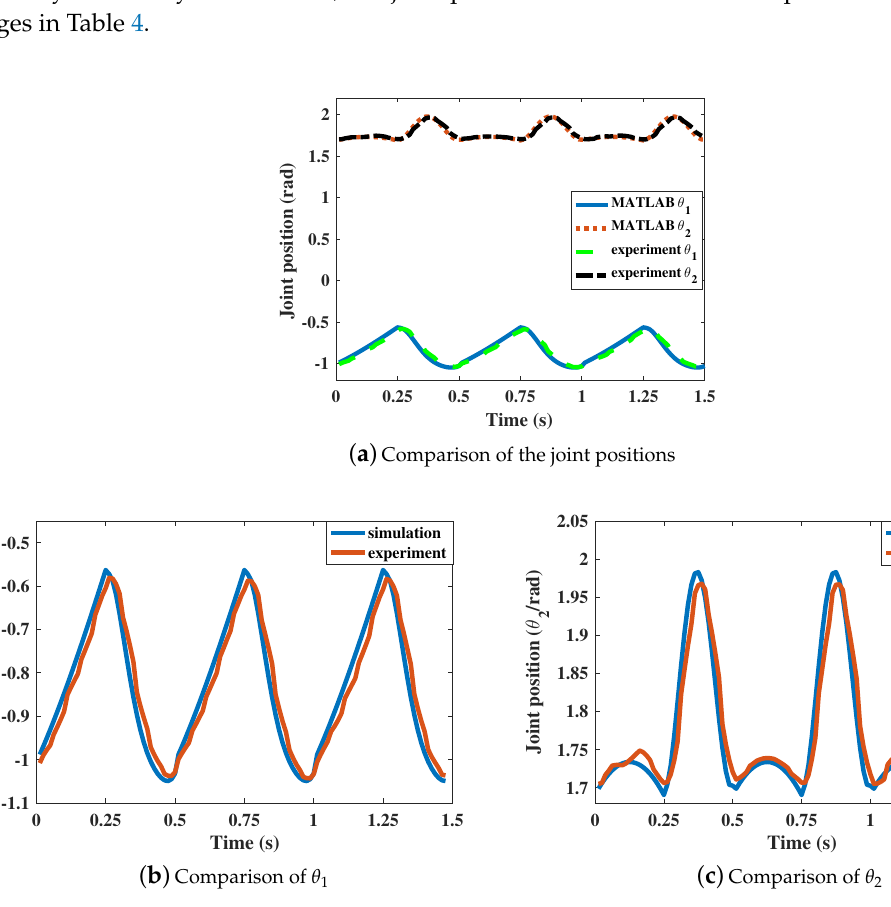
Figure 20. Curves of the joint positions using energy efficient